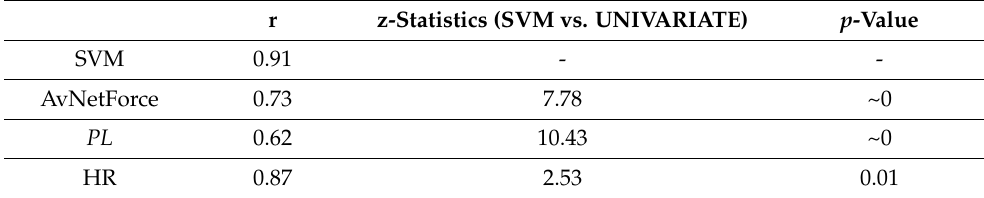
Table 2. The table reports the correlation coefficients of the multivariate and univariate cross- validated approaches ( p ~ 0) and the results of the statistical comparison between the multivariate and univariate